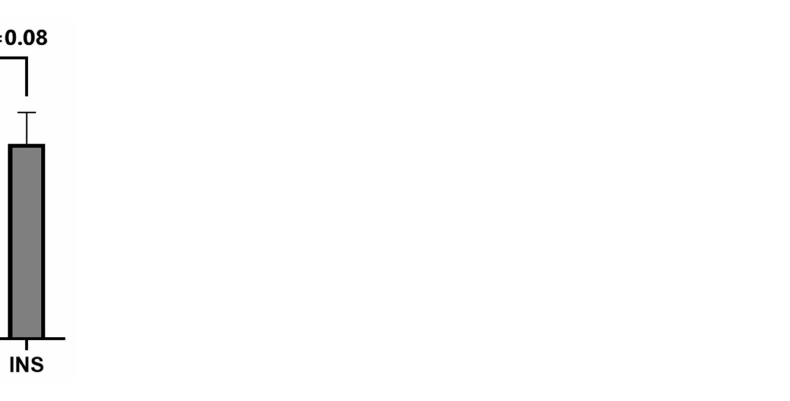
Figure 6. Elevated plasma BUN level in two-moderate-dose STZ-induced DN model was suppressed by insulin treatment ( n = 5). Data are presented as means ± S.E. ** p < 0.01 as determined by ANOVA followed by Dunnett’s test. DN = Diabetic Nephropathy, C = Control, INS = Insulin